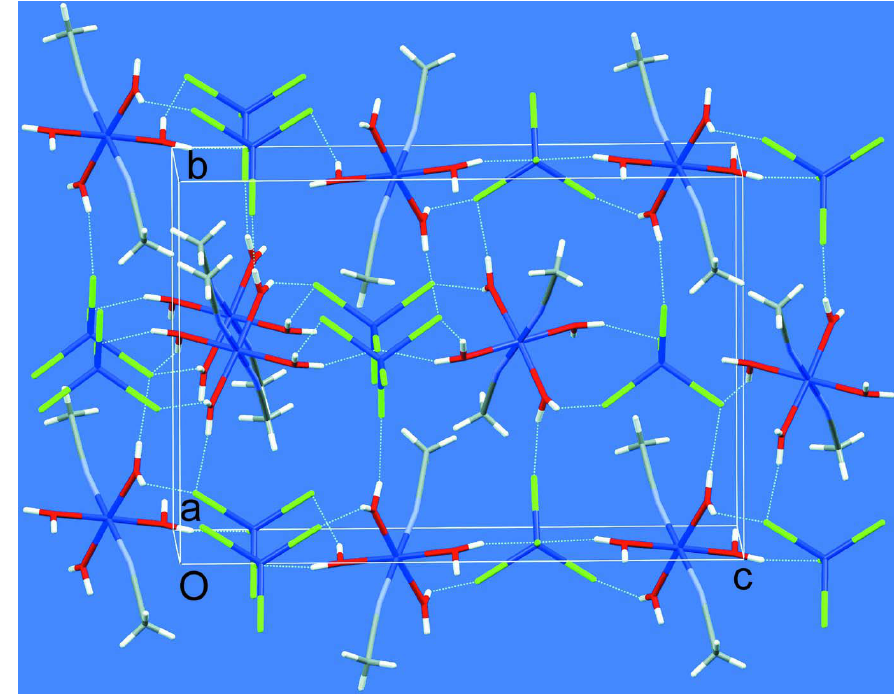
Figure 2 The crystal packing as seen approximately along a direction (Macrae et al. , 2008). Hydrogen bonds are depicted as dashed